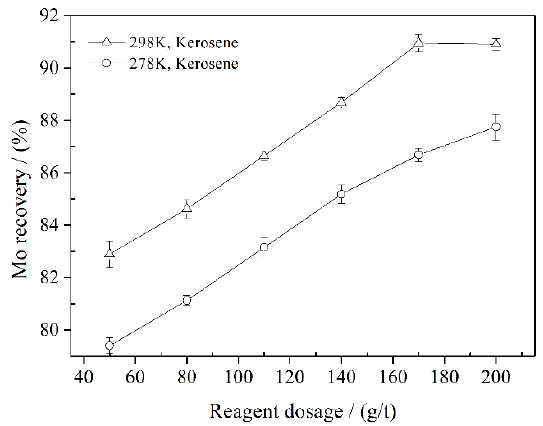
Figure 3. The influence of low-temperature pulp on the flotation performance of kerosene.